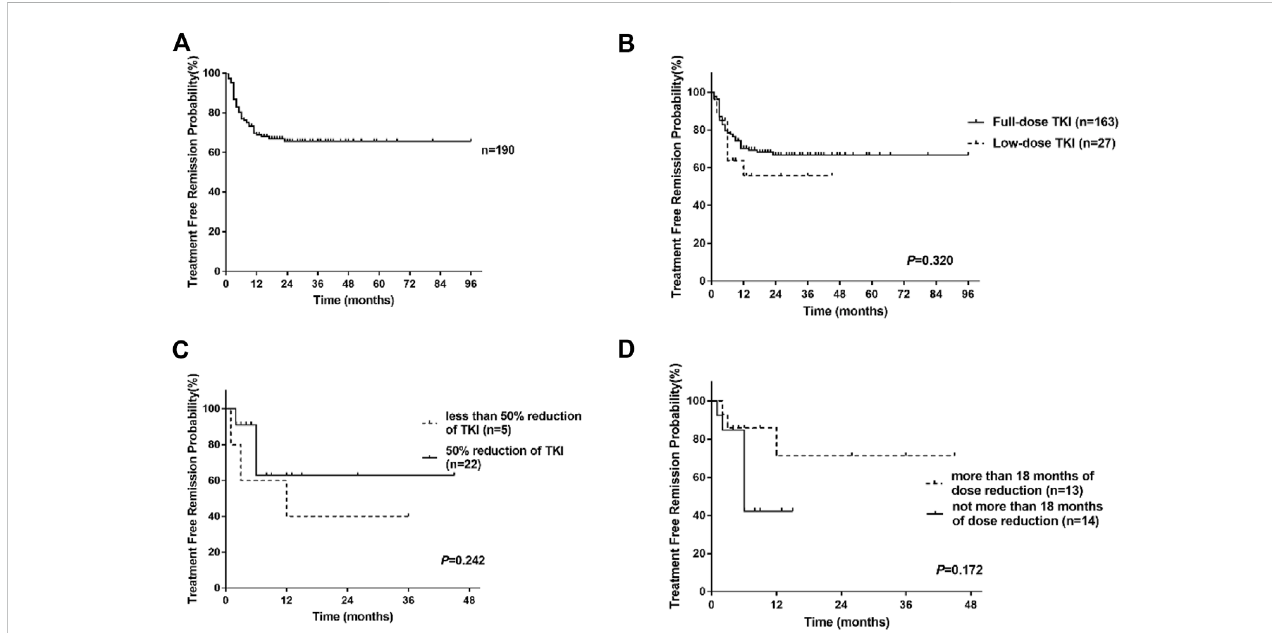
FIGURE 2 Treatment-freeremission(TFR)aftertyrosinekinaseinhibitor(TKI)therapy. (A) TFRintheoverallpatients. (B) TFRinpatientsaccordingtothedoseofTKI. (C) TFR in patients with low-dose TKI according to the degree of TKI reduction. (D) TFR in patients with low-dose TKI according to the duration of dose